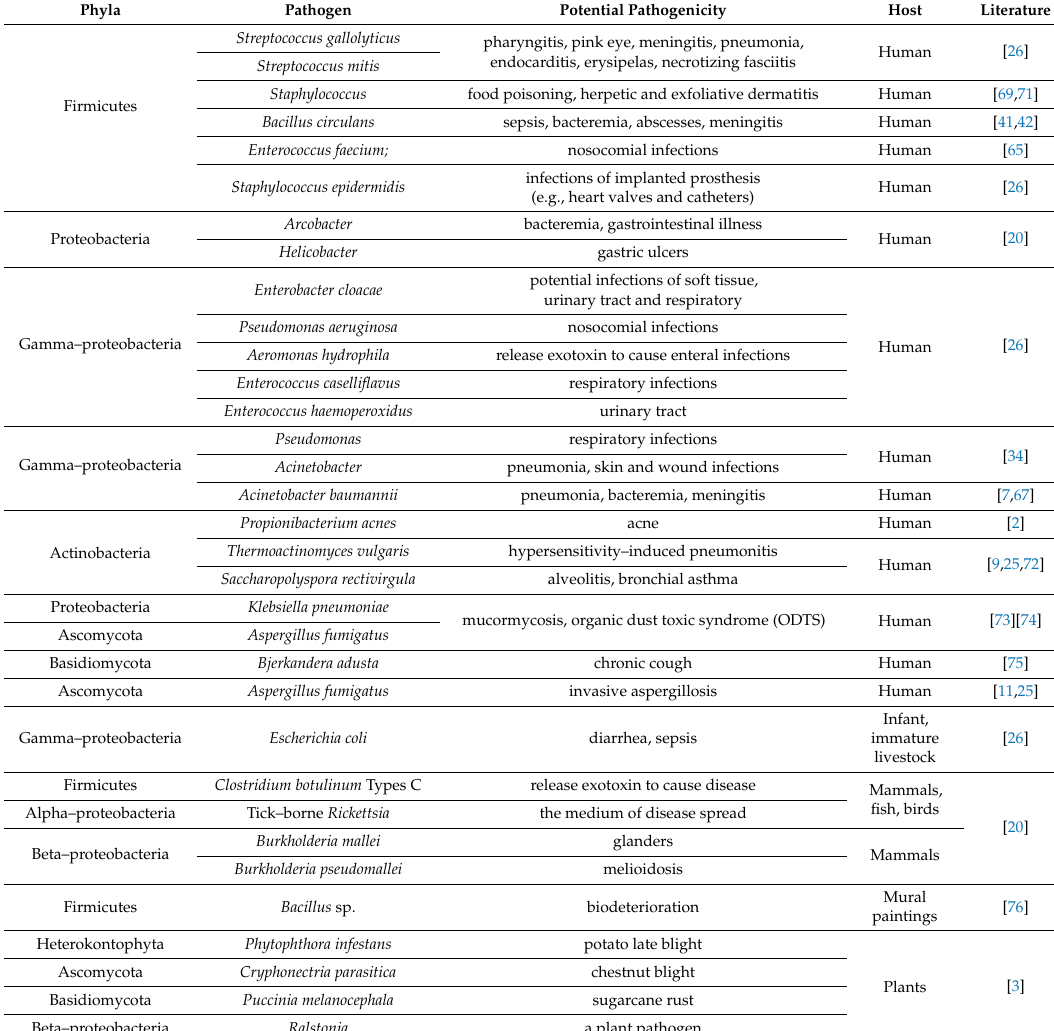
Table 3. Pathogens detected in di ff erent